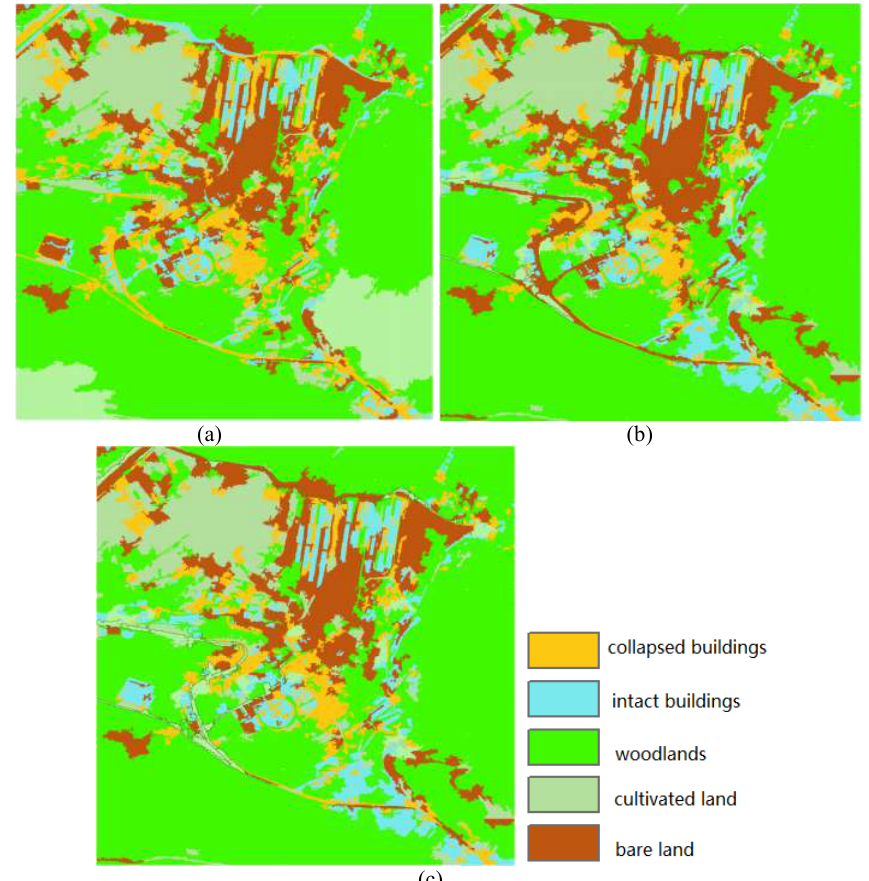
Figure 6. Classifition image obtained by different methods (a) Spectral-texture features; (b)Spectral-AlexNet features; (c) AlexNet features